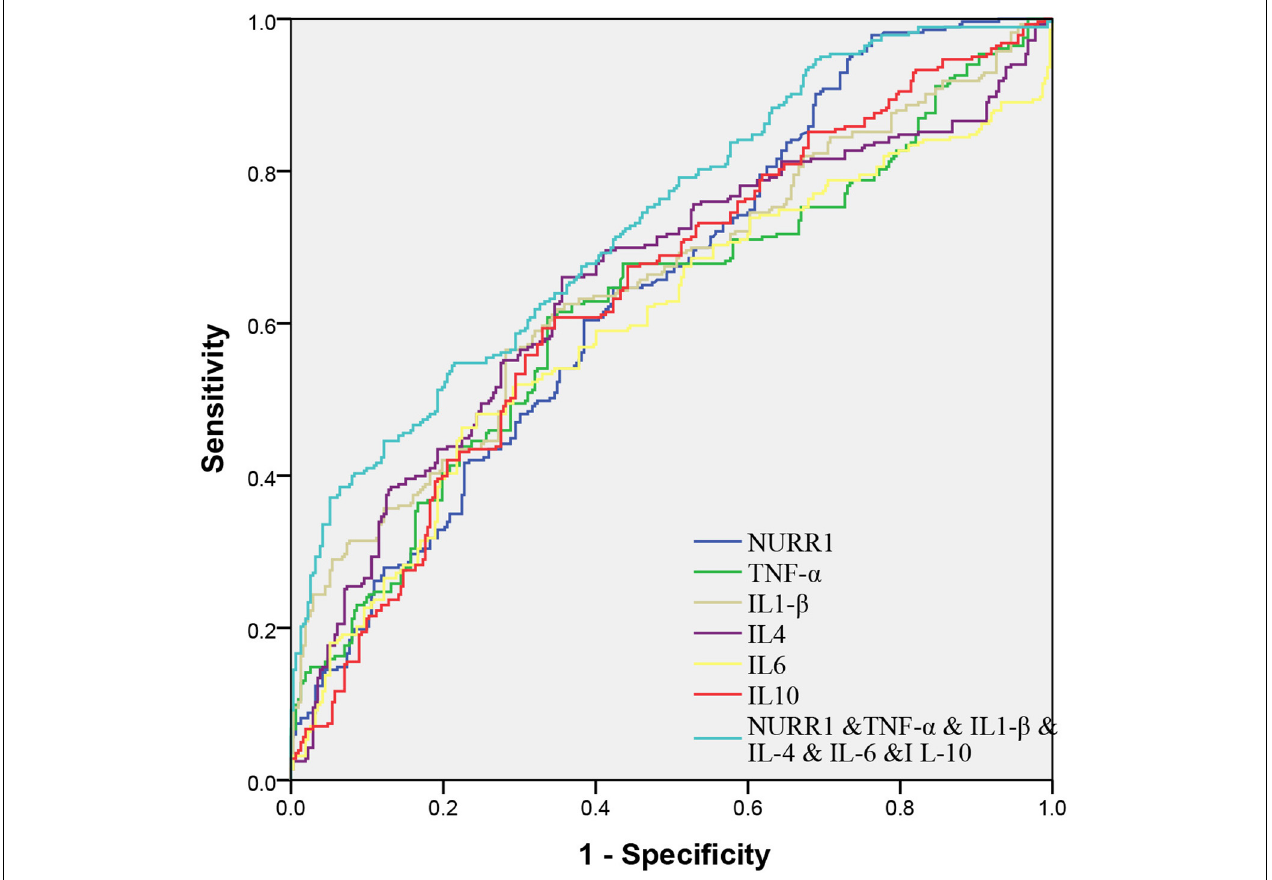
FIGURE 5 | Receiver operating characteristic curves for NURR1 , TNF- α , IL-1 β , IL-4 , IL-6, and IL-10 of PD versus HC. The AUCs value of the combination of NURR1 with cytokines was 0.73 (95% CI, 0.69–0.77; p < 0.05), which was out performed those of NURR1 , TNF- α , IL-1 β , IL-4 , IL-6 , and IL-10 alone.